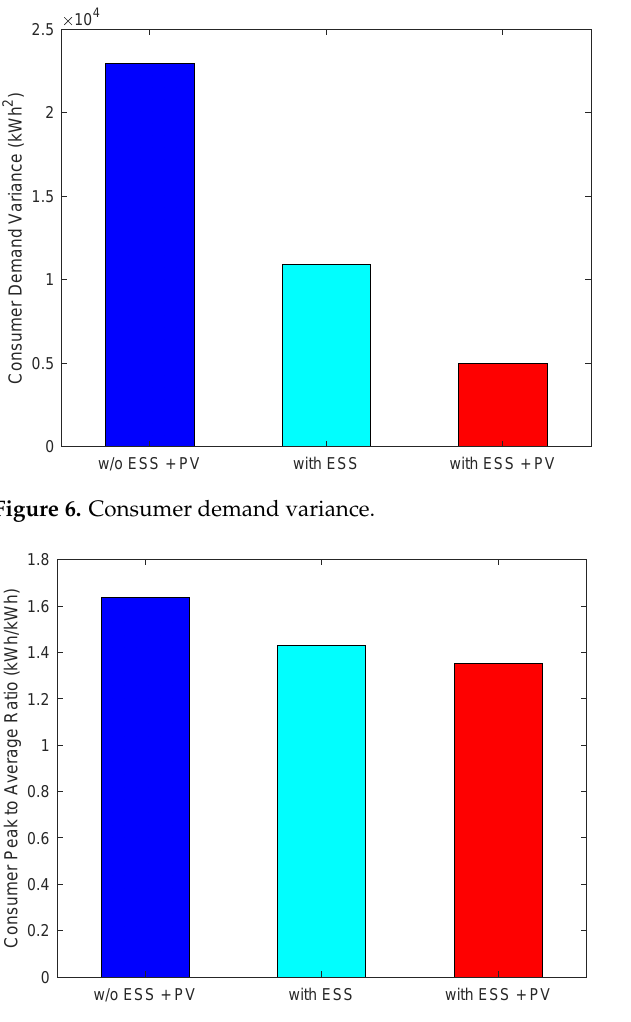
Figure 7. Consumer peak to average